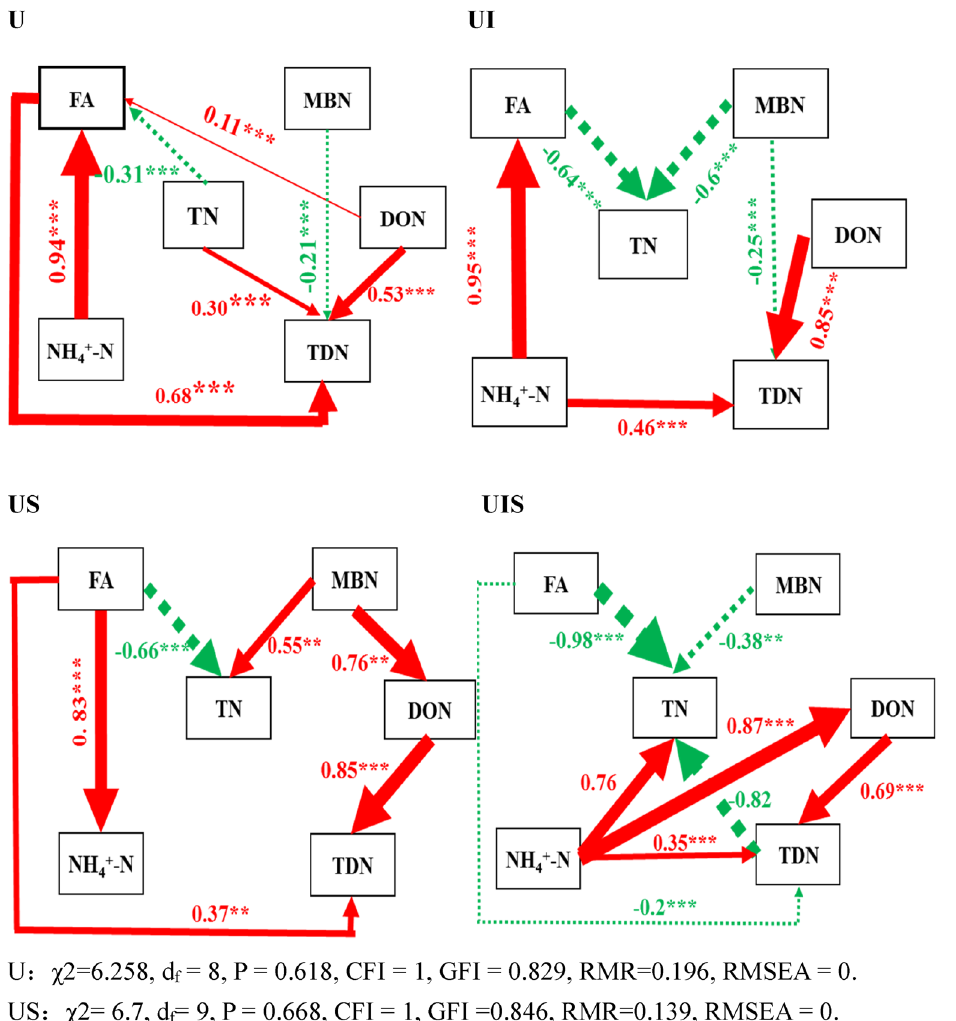
Figure 2. Structural equation model analysis for the contribution of urea-N to soil total nitrogen retention. The numbers on the arrows are normalized path coefficients. The thickness of the arrow is proportional to the size of the path coefficient. Continuous arrows and dotted arrows indicate positive and negative correlations, respectively. Asterisks after data indicates a significant difference (* P < 0.05, ** P < 0.01, *** P < 0.001). U: 15 N labeled urea; US: 15 N labeled urea + straw; UI: 15 N labeled urea + inhibitor; UIS: 15 N labeled urea + inhibitor + straw. FA stands for fixed ammonium derived from urea; MBN stands for microbial biomass nitrogen derived from urea. DON represents soluble organic nitrogen derived from urea; TN represents total nitrogen derived from urea sources; NH 4+ -N denotes ammonium nitrogen derived from urea. TDN represent total dissolvable nitrogen derived from urea. Some variables have no arrows because in the operation of maximum likelihood number method, the route with relatively small path coefficient is removed in order to make the model more fit and more in line with the fitting index described below in the